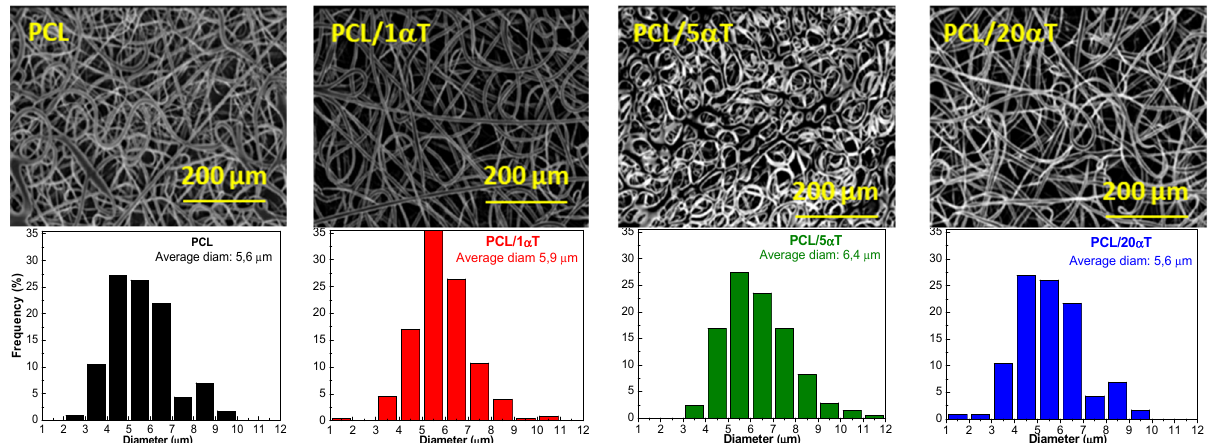
Figure 5. SEM images and fiber diameter distributions of electrospun fibers of PCL with 1, 5 and 20 wt% α tocopherol content.